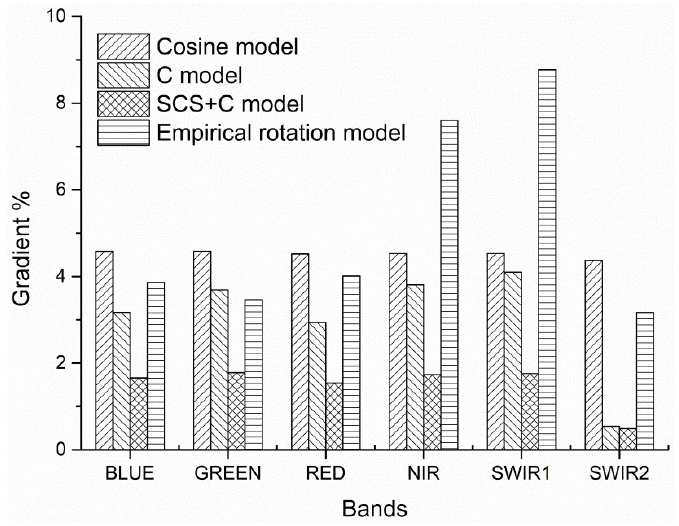
Figure 6. Percent change in band reflectance over water bodies after topographic correction by each of the four models.